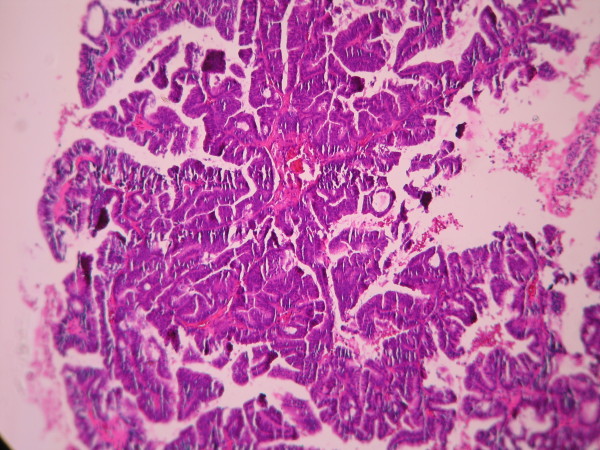
Endometrial adenocarcinoma. Extensive papillary pattern. (Low power)